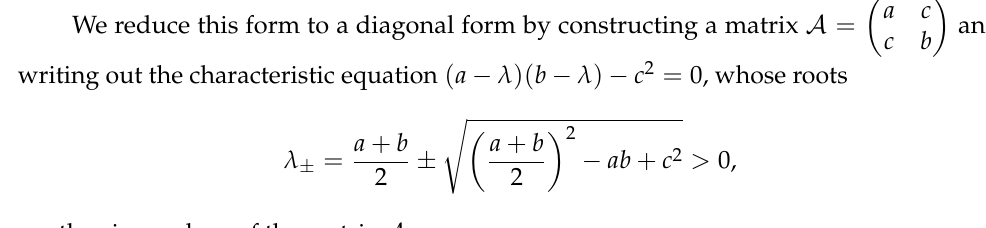
Figure 1. Representation of a training sample on a straight line by a set of characters × , •